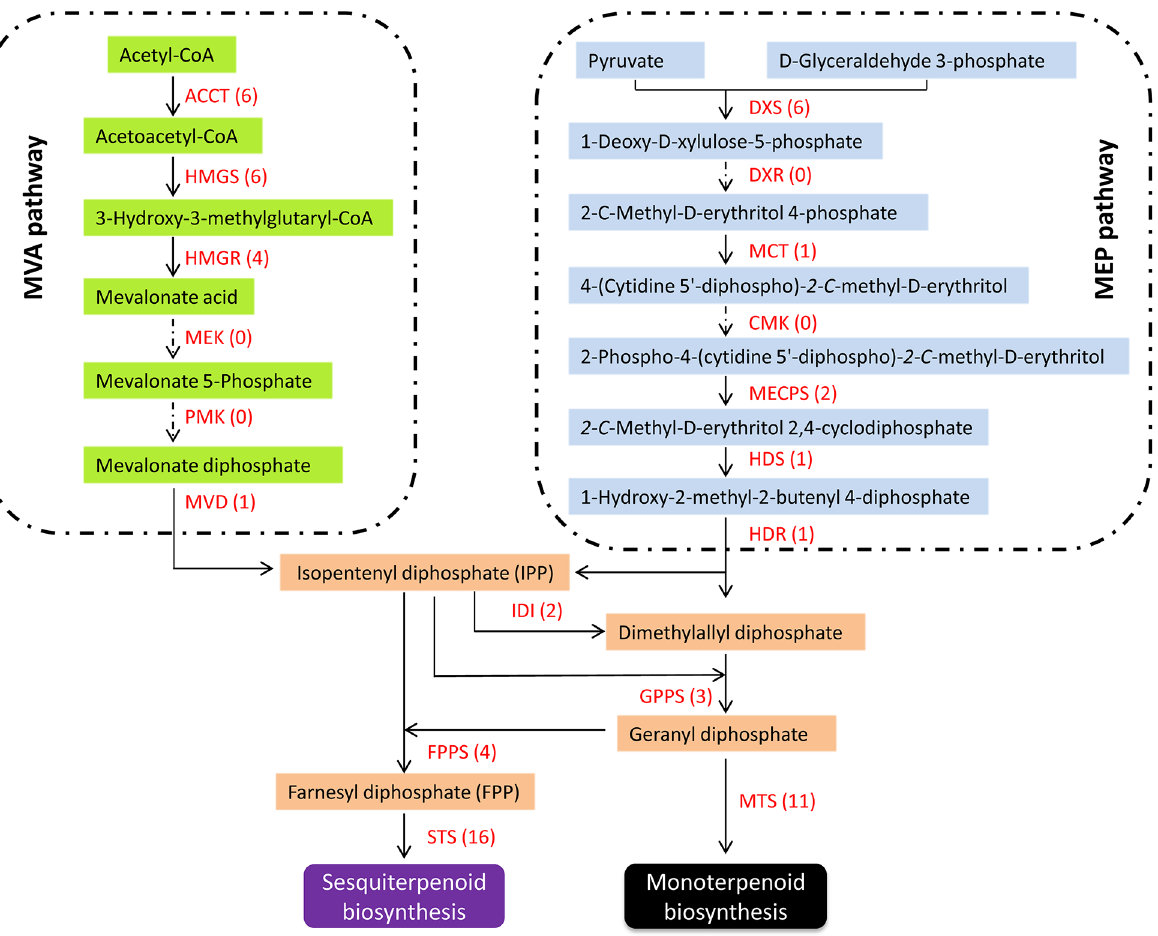
Fig 4. Putative structural genes involved in terpenoid backbone biosynthesis pathway. The values in the bracket indicate the number of unigenes in the corresponding gene families. ACCT, acetyl-CoA C-acetyltransferase; HMGS, hydroxymethylglutaryl-CoA synthase; HMGR, hydroxymethylglutaryl-CoA reductase; MVK, mevalonate kinase; PMK, phosphomevalonate kinase; MVD, mevalonate diphosphate decarboxylase; DXS, 1-deoxy-D-xylulose- 5-phosphate synthase; DXR, 1-deoxy-D-xylulose-5-phosphate reductoisomerase; MCT, 2-C-methyl-D-erythritol 4-phosphate cytidylyltransferase; CMK, 4-diphosphocytidyl-2-C-methyl-D-erythritol kinase; MECPS, 2-C-methyl-D-erythritol 2,4-cyclodiphosphate synthase; HDR, 4-hydroxy-3-methylbut-2-enyl diphosphate reductase; HDS, (E)-4-hydroxy-3-methylbut-2-enyl-diphosphate synthase; IDI, isopentenyl-diphosphate delta-isomerase; GPPS, geranyl diphosphate synthase; FPPS, farnesyl diphosphate synthase; STS, Sesquiterpenoid synthase; MTS, Monoterpenoid synthase.